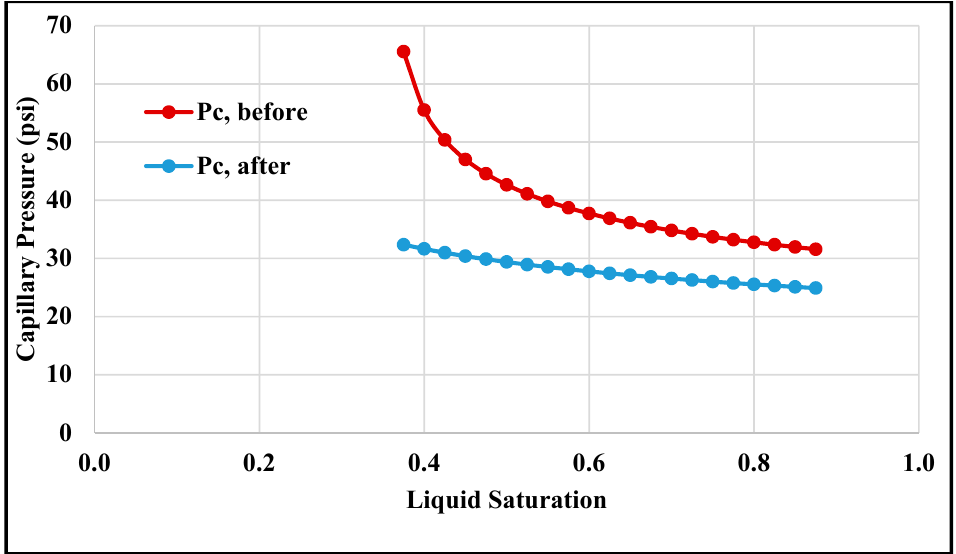
Figure 10. Capillary pressure curves before and after thermochemical treatment.